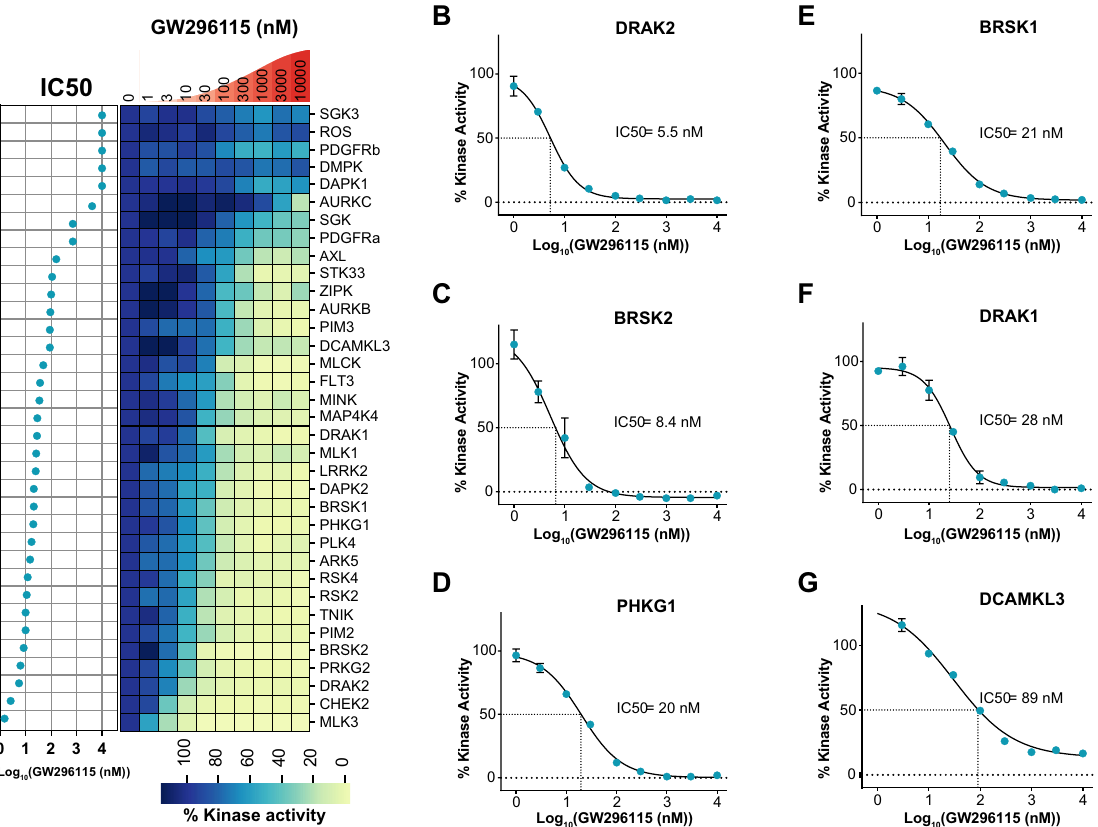
Figure 2. Dose–response kinase enzymatic activity assays on 35 kinases treated with GW296115 reveal its biochemical potency. ( A ) Heatmap of % kinase activity with 9-point dose response to GW296115, plotted in descending order of IC 50 values from Eurofins screen (N = 2). ( B – G ) Dose response curves for IDG kinases with IC 50 < 100 (N = 2): DRAK2 (IC 50 = 5.5 nM), BRSK2 (IC 50 = 8.4 nM), PHKG1 (IC 50 = 20 nM), BRSK1 (IC 50 = 21 nM), DRAK1 (IC 50 = 28 nM), and DCAMKL3 (IC 50 = 89 nM), respectively. Python version 3.8 was used to make heatmap in ( A